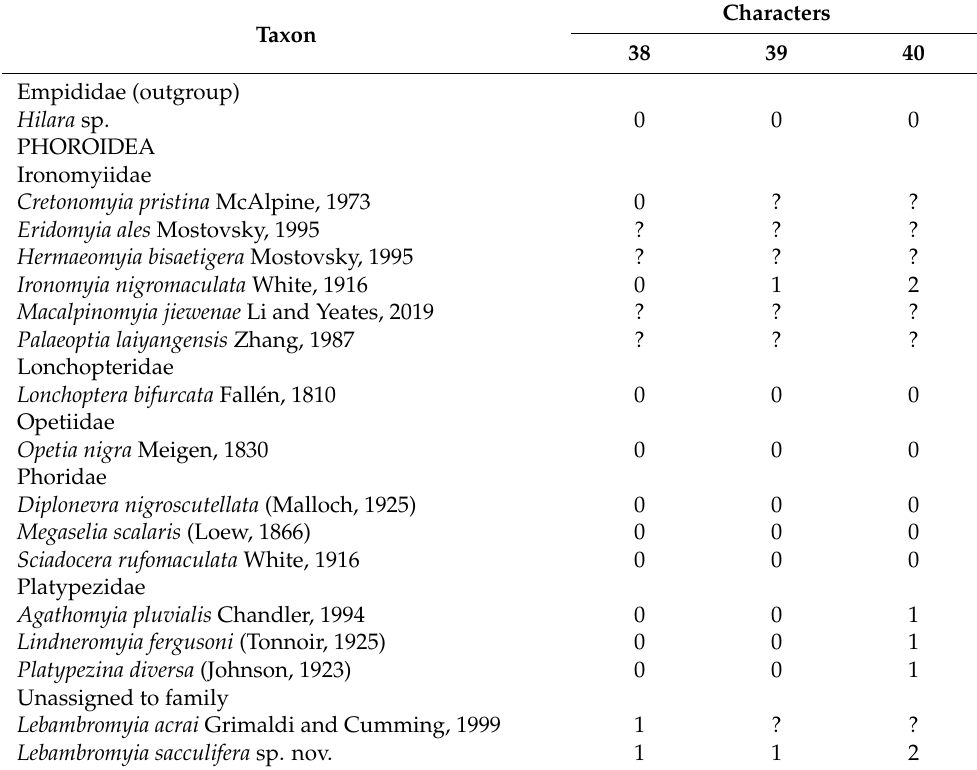
Table 2. Scoring of the additional characters in the morphological dataset of Li and Yeates [8]. Taxon